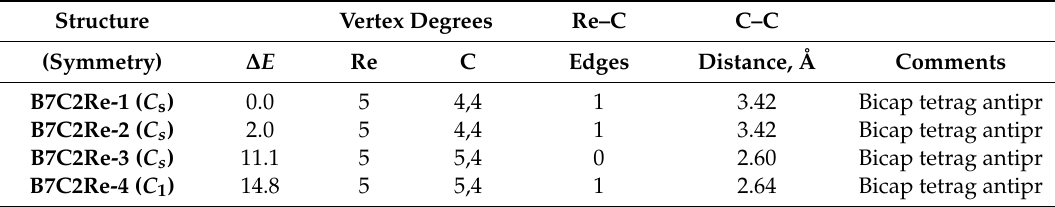
Figure 5. The four optimized lowest energy 10-vertex C 2 B 7 H 9 Re(CO) 2 (NO) structures. Table 3. The four optimized 10-vertex C 2 B 7 H 9 Re(CO) 2 (NO) structures within 16 kcal / mol of the lowest energy structure.